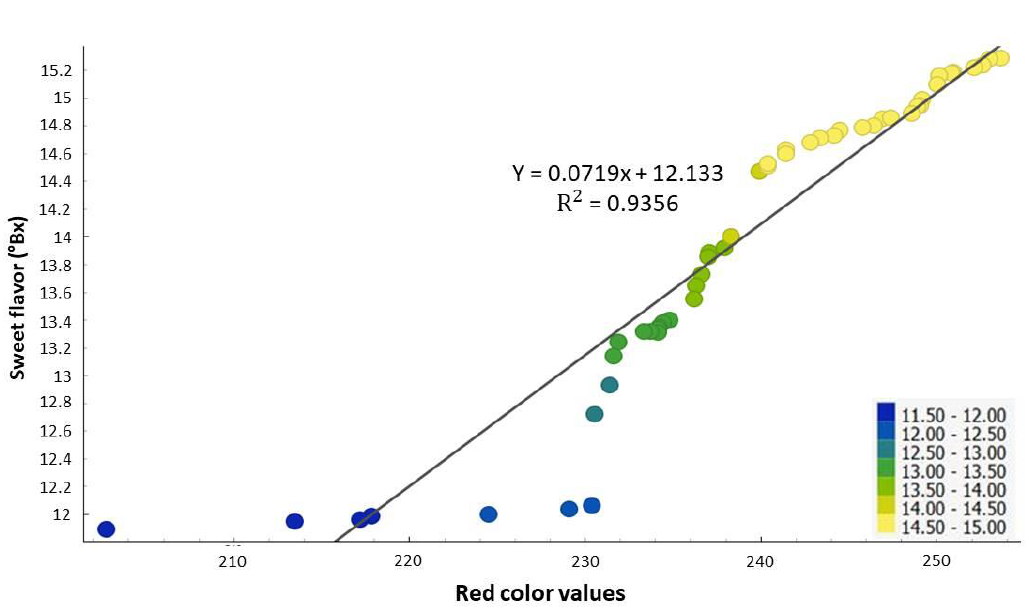
Figure 9. The relationship between orange fruits’ red color values and sweetness.